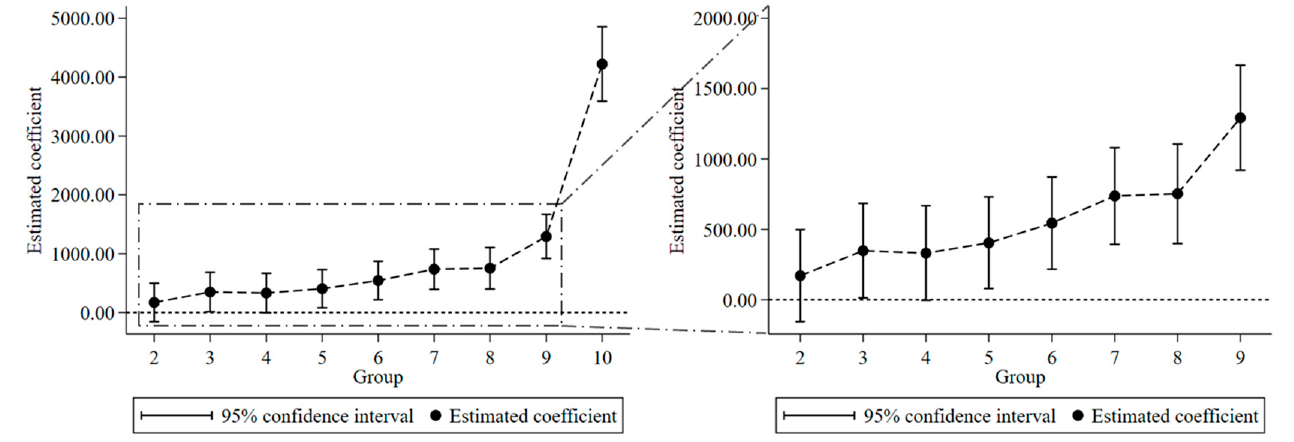
Figure 3. Estimated results of Model